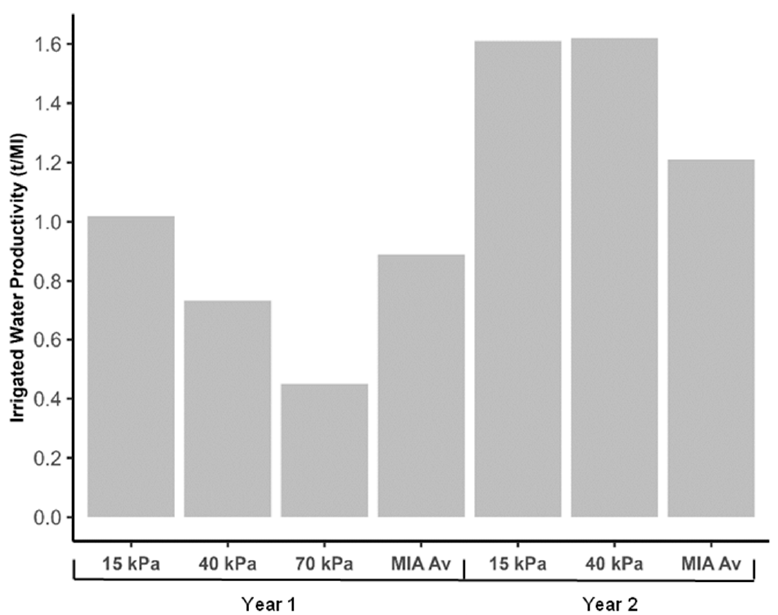
Figure 6. Irrigated water productivity of aerobic rice versus Murrumbidgee (MIA) regional average (all rice varieties) in Year 1 and Year 2 of the study [50–52].